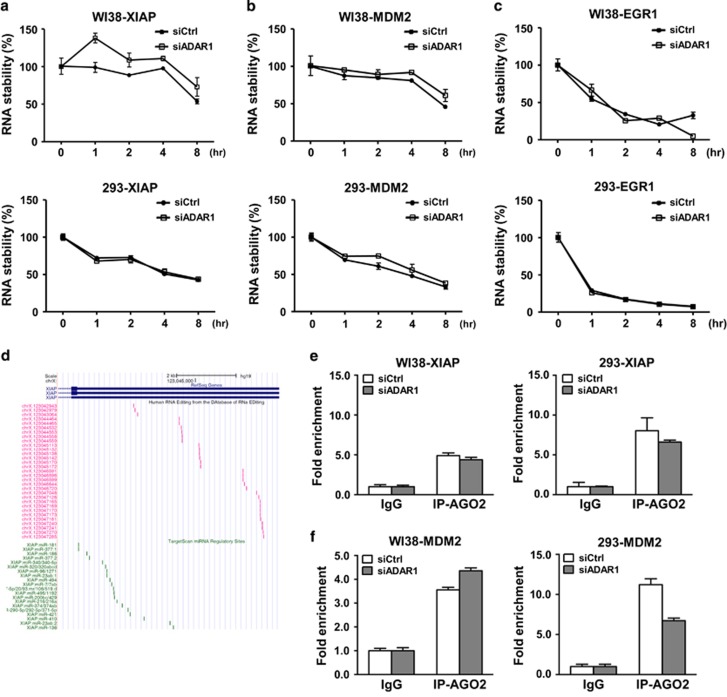
The post-transcriptional regulatory role of ADAR1 is independent of RNA stability and microRNAs targeting. (a and b) RNA stability of the XIAP (a) and MDM2 (b) transcripts was measured in WI38 (top) and 293 (bottom) cells harboring control (siCtrl) or ADAR1-targeting (siADAR1) siRNAs. Dynamic changes in the abundance of XIAP and MDM2 mRNAs post-transcription block (by actinomycin D treatment) were measured by real-time PCR and plotted relative to the initial time point. (c) The dynamic turnover of EGR1 transcripts was monitored as above and serves as the positive experimental control. (d) An UCSC Genome Browser-based scheme depicting the relative locations of annotated RNA editing sites (red ticks) and miRNA binding sites (green ticks) in the XIAP 3′ UTR. (e and f) RIP assay was performed, using control antibody (IgG) or antibody against AGO2 (IP-AGO2), to assess AGO2’s occupancy of the XIAP (e) and MDM2 (f) transcripts in ADAR1-depleted WI38 (left) and 293 (right) cells. The graphs represent the quantitative determination of bound RNA corresponding to target 3′ UTR in the immunoprecipitates, as determined by quantitative RT-PCR. Data presented are normalized to the values of IgG and shown as mean±S.D.